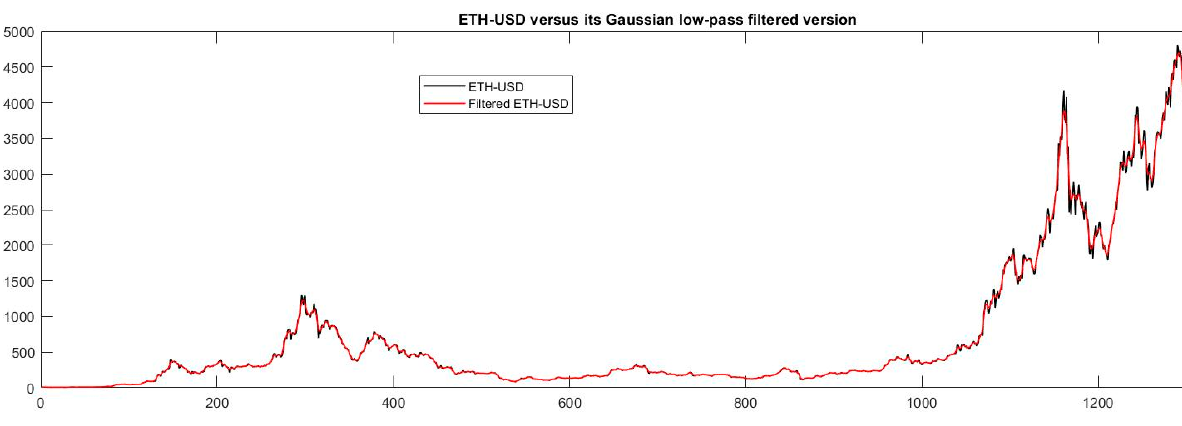
Figure 15. ETH–USD data set versus its filtered version.